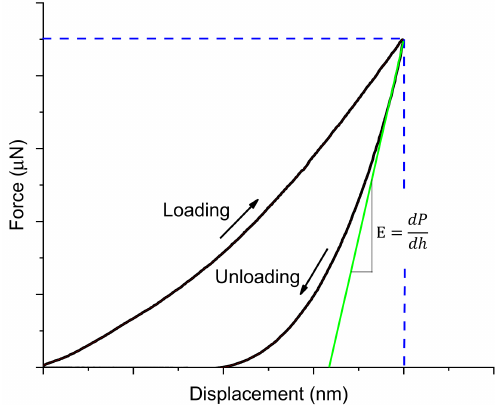
Figure 3. Typical load-displacement curve in a nanoindentation test (E represents Young’s modulus) (modified from Jha et al. [38])